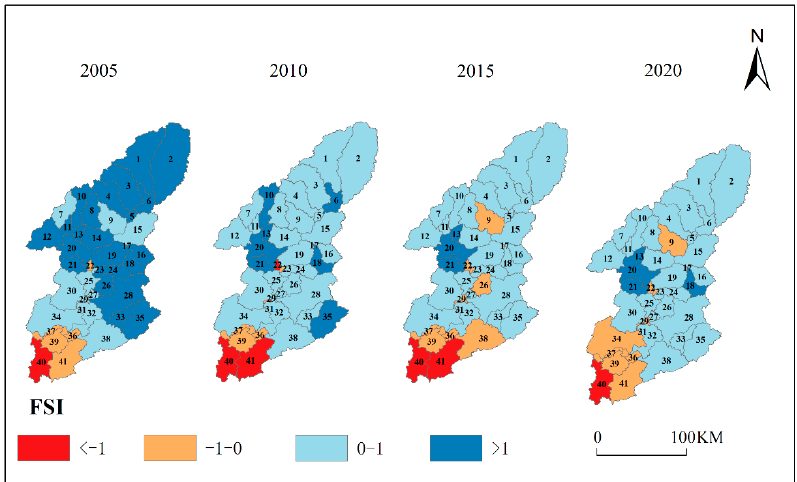
Figure 7. Balance of supply and demand of